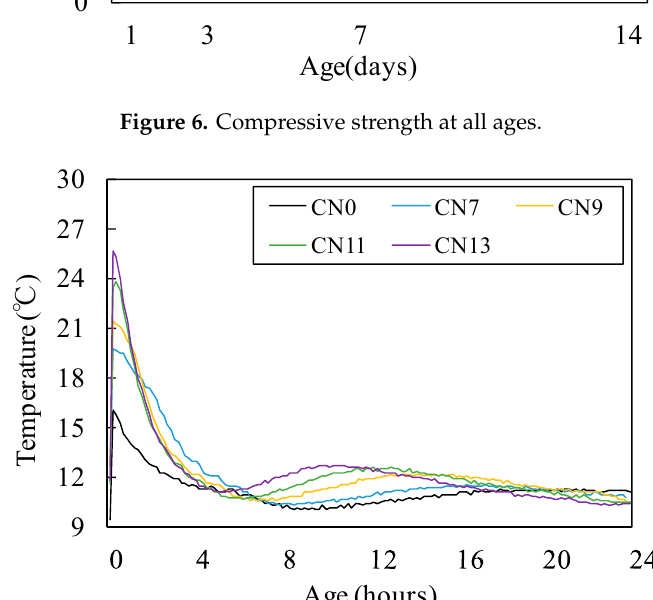
Figure 7. Temperature history (24 h).